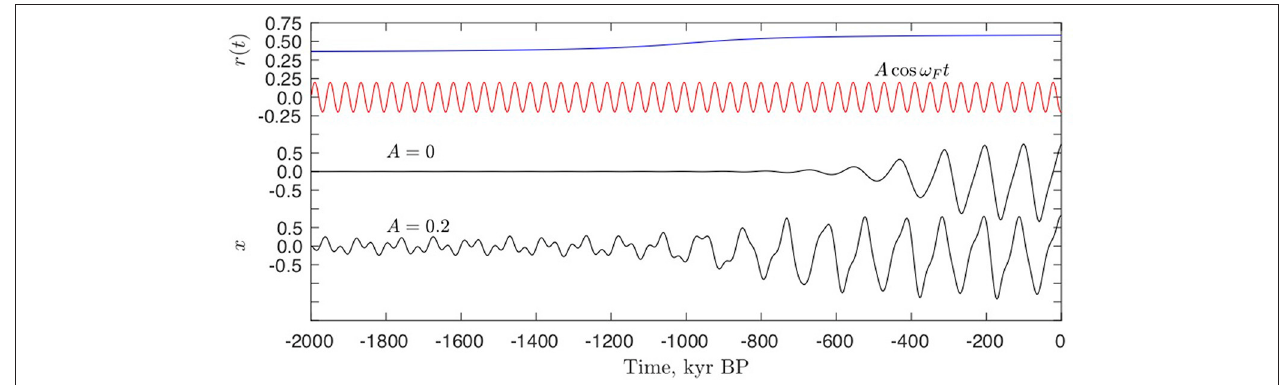
FIGURE 9 | By a slow change of the parameter r (top blue curve) the system (6) passes through a Hopf bifurcation. The other parameters are fixed: ( p , q , s ) = (1.0,1.2,0.8). The two lower black curves are the x variable in the autonomous case ( A = 0) and in the forced case ( A = 0.2). The autonomous system reaches the Hopf bifurcation for r = 0.35. The red curve is the forcing.